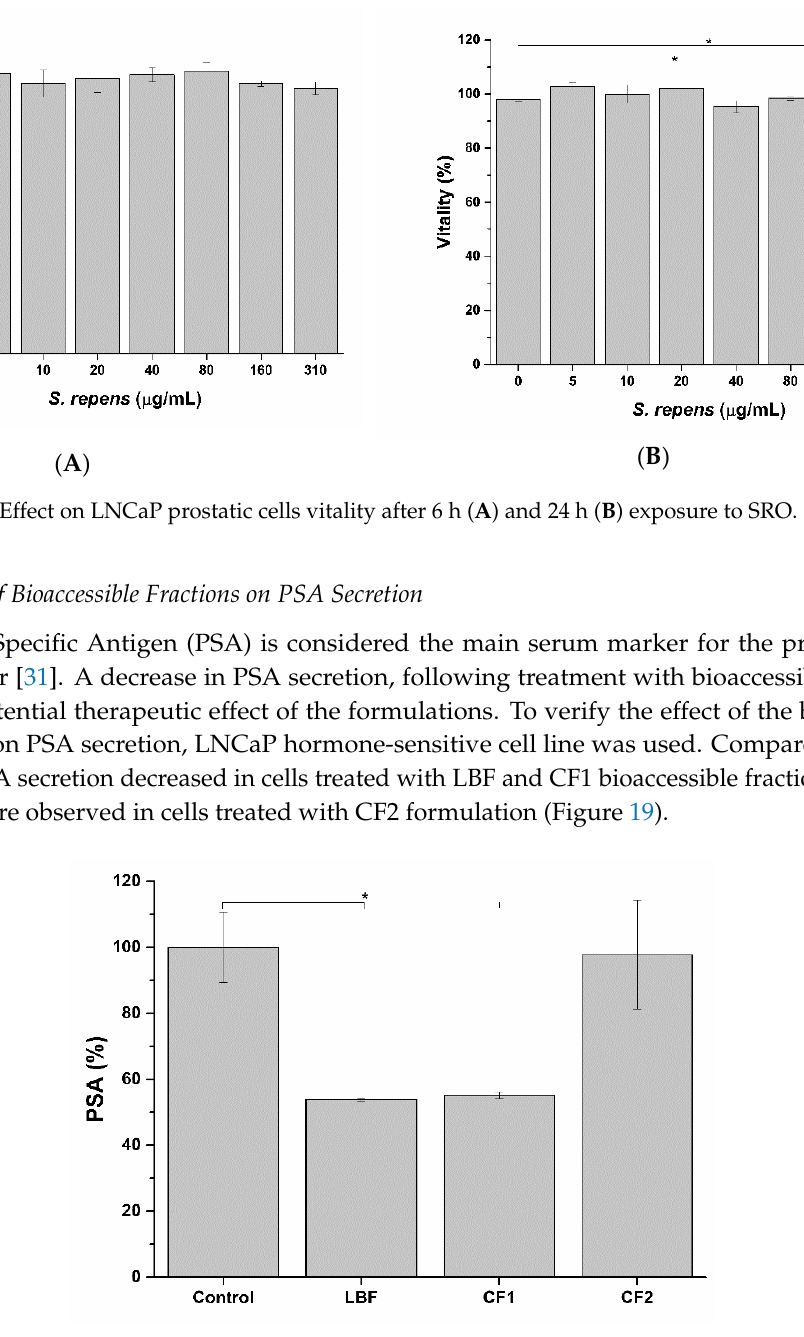
Figure 17. Pro-apoptotic activity of bioavailable fractions on LNCaP prostatic cells: LBF: 22% SRO; CF1: 18.8% SRO; CF2: 3.2% SRO (Table 6). Diclofenac was used at 32 µg/mL. CM: Conditioned